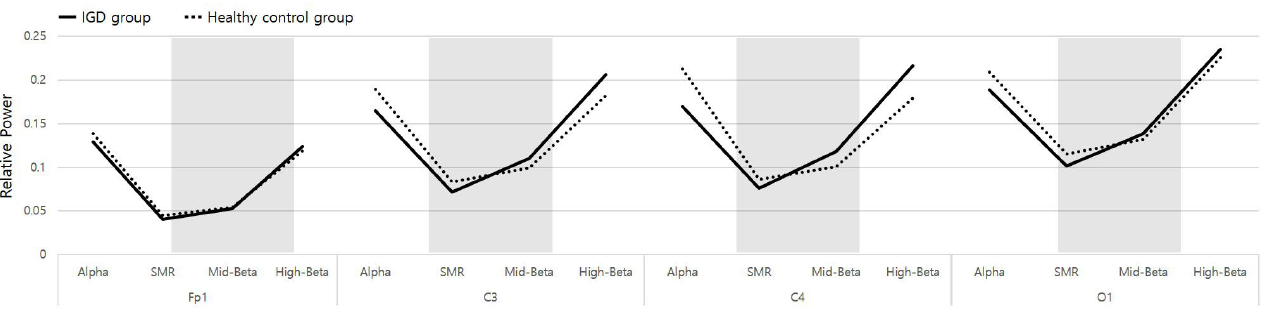
Figure 6. Crossing phenomenon was observed (shading area) and presented at four lobes when Alpha was at 8–12 Hz, SMR at 12–15 Hz, MidBeta at 15–20 Hz, and HighBeta at 20–30